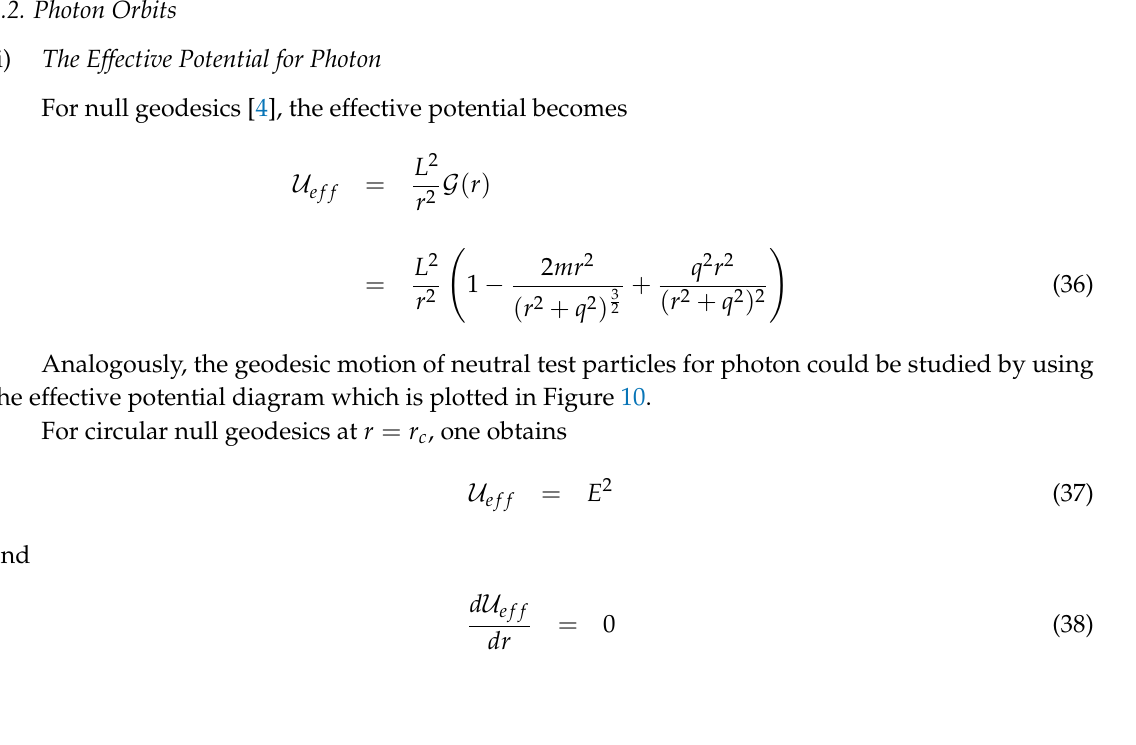
Figure 9. The figure demonstrates the variation of H ( u ) with u for ABG